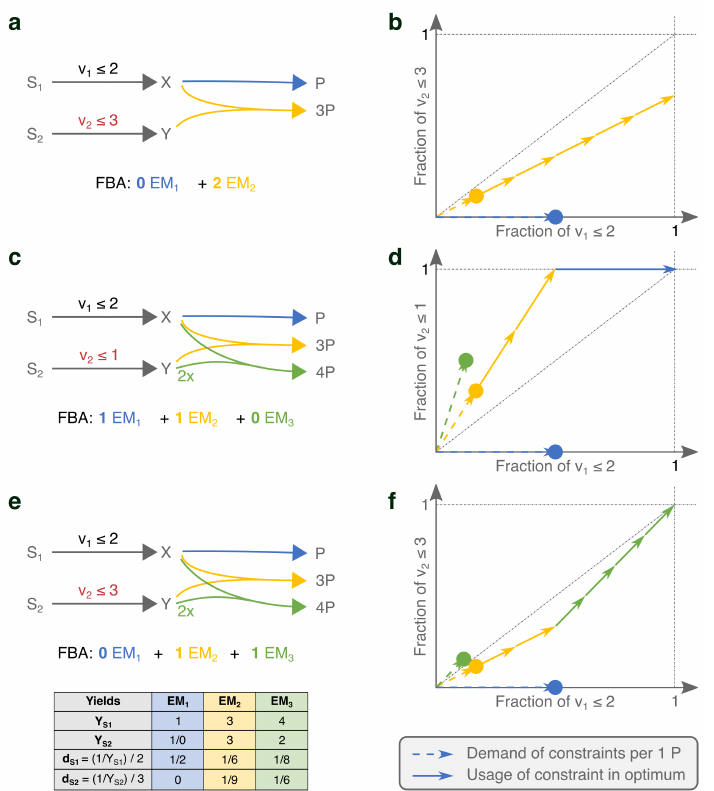
Figure 1. Small networks show that the product-yields on limiting substrates in combination with the values of the upper bounds determine which EMs are selected in an FBA-solution. Panels ( a , c , e ) show networks of increasing complexity and the resulting FBA solutions. In ( b , d , f ), we show the respective visualizations of the costs of the various EMs with respect to the limited nutrient supplies. The dots indicate the fractions of the constrained supplies that the corresponding EM would use for producing one P . The dashed vectors help to emphasize that the costs of a combination of EMs can be visualized by using vector addition (as in [24]), but for visualization purposes, these dashed vectors will not be used in subsequent figures. The solid vectors show the usage by the various EFMs of the limited supplies in the FBA solution. The computation of the vector-positions is explained in the main text, and a calculation example is shown in ( e ). ( a , b ) show that the maximal yield EM is selected if there is only one active constraint. In ( c , d ) the uptake of S 2 becomes limiting as well. Since the yellow and blue EMs are now selected, this illustrates that the product-yields on both substrates together determine which EMs are selected under two active constraints. We added the green EM to contradict that the maximal-yield EMs would always be selected. By relaxing the limit on the uptake of S 2 in ( e , f ), we show that the precise values of the constraint bounds influence the selection of EFMs as